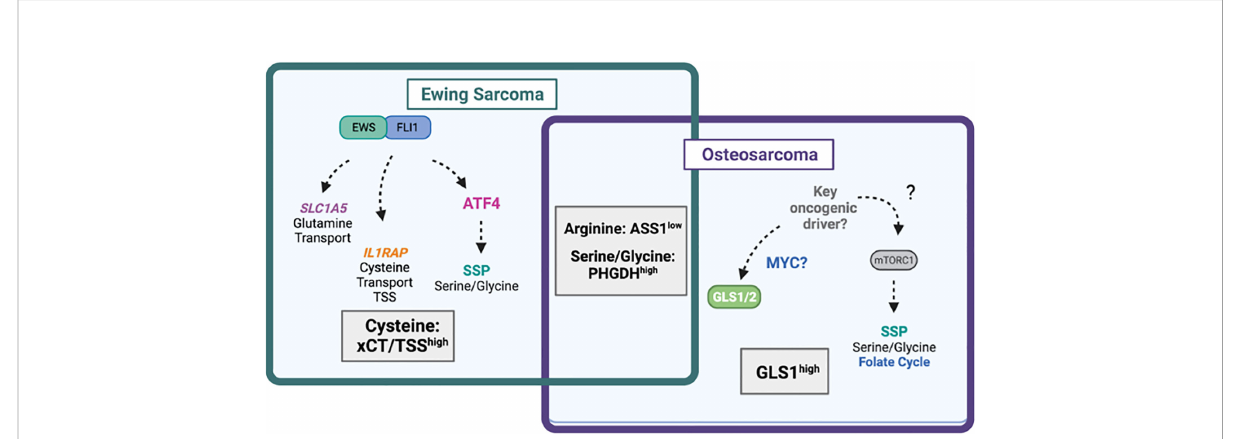
FIGURE 4 Amino acid dependencies in Ewing sarcoma and osteosarcoma. Venn-diagram depicting shared and unique amino acid vulnerabilities in Ewing sarcoma and osteosarcoma. The EWS::FLI1 fusion protein has been shown to directly regulate expression of glutamine transporter SLC1A5 (ASCT2) leading to high glutamine import. EWS::FLI1 also regulates expression of IL1RAP and downstream cysteine availability via the transsulfuration pathway (TSS) and xCT ( SLC7A11 ). EWS::FLI1 indirectly regulates the serine biosynthesis pathway (SSP) via ATF4. In osteosarcoma, the SSP also drives tumorgenicity through unde fi ned mechanisms likely involving mTORC1. The mitochondrial enzyme GLS1, which may be under the control of MYC is highly expressed in osteosarcoma and predicts worse survival. Diagram was created with